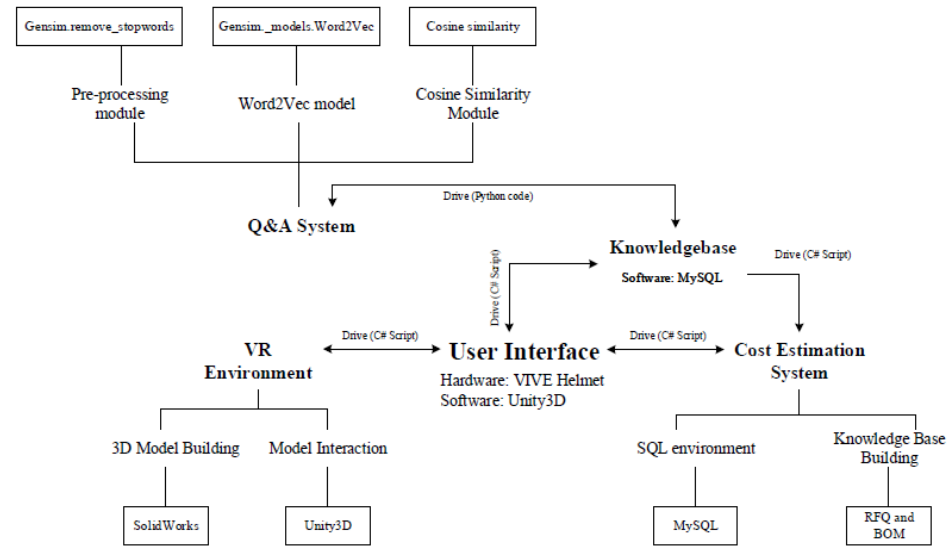
Figure 9. Hardware and software integration of the proposed chatbot system.